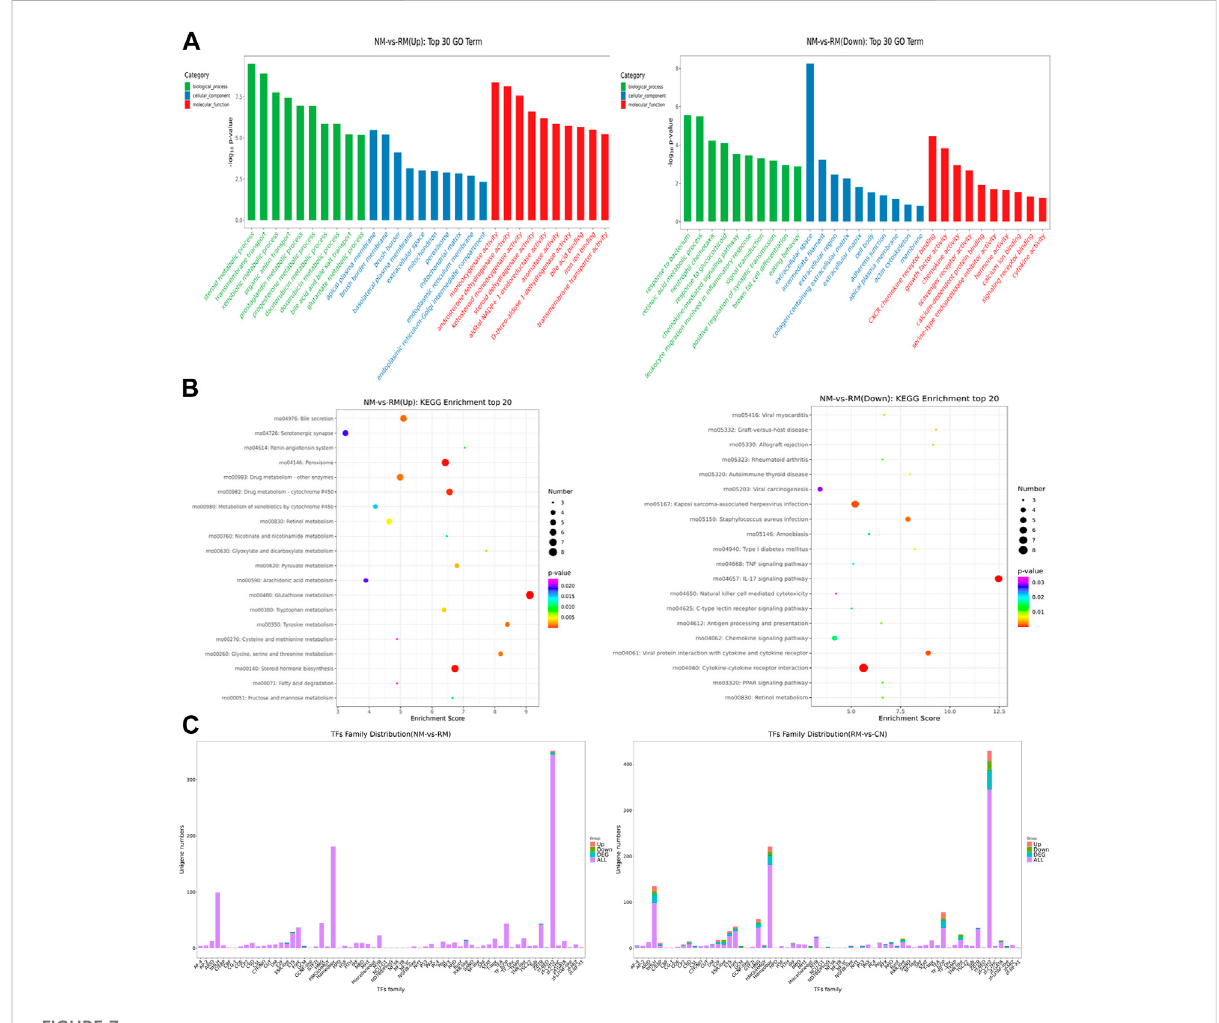
FIGURE 7 GO term and KEGG pathway enrichment analyses of DEGs. (A) GO annotations of DEGs were queried into functional groups based on enrichment scores. (B) The top 20 up or down regulated pathways are presented. The enrichment factor is the ratio of the number of DEGs to the number of total genes in a particular pathway. The dot size represents the number of DEGs, while colors correspond to the range of p -values. (C) Predicted transcription factors of DEGs. Red represents upregulated genes and blue represents downregulated